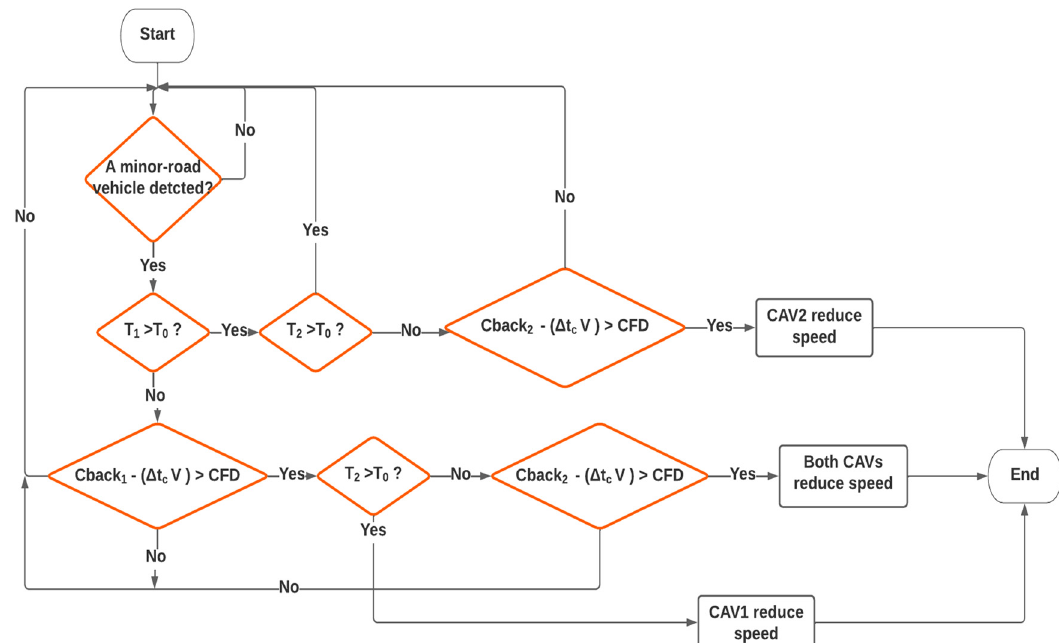
Figure 9: Control logic for a left - turn vehicle in mixed tra ffi c fl